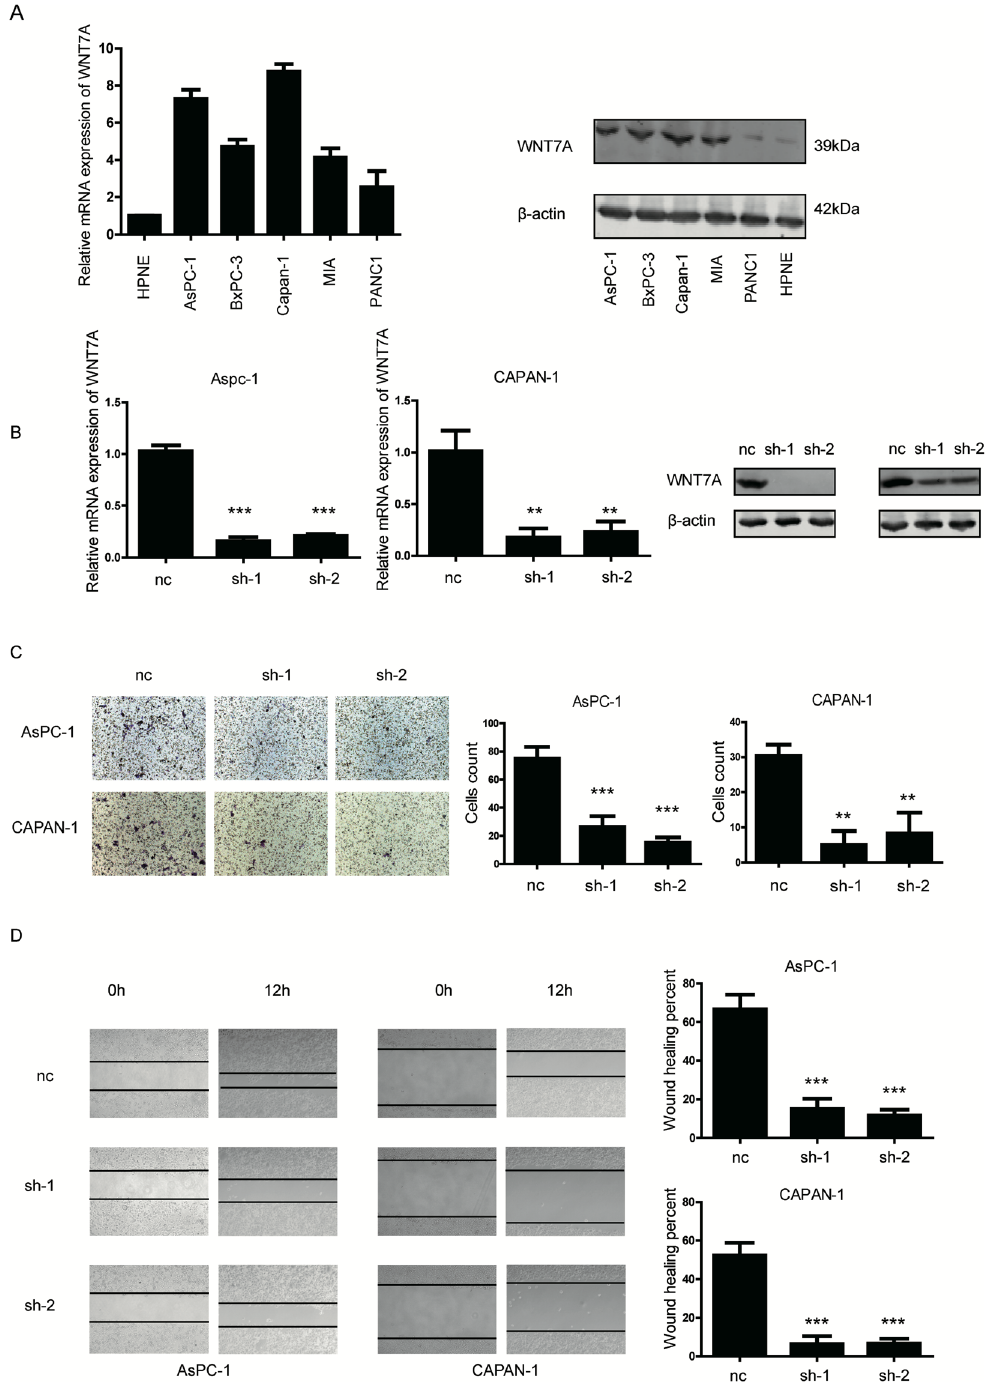
Figure 3. WNT7A is overexpressed in PDAC cell lines and interference of WNT7A expression inhibits the migration capacity of pancreatic cancer cells. ( A ) The mRNA and protein levels of WNT7A were detected in five different PDAC cell lines and a nonmalignant cell line hTERT-HPNE by qRT-PCR and Western blot respectively. ( B ) The expression of WNT7A at mRNA and protein level were determined by qRT-PCR and Western blot respectively in cells transfected with negative control and wnt7a shRNA plasmid. ( C ) Impact of WNT7A expression interference on two PDAC cell lines’ migration capacity in transwell assays. ( D ) Impact of WNT7A expression interference on two PDAC cell in wound healing assays. ** P < 0.01, *** P <